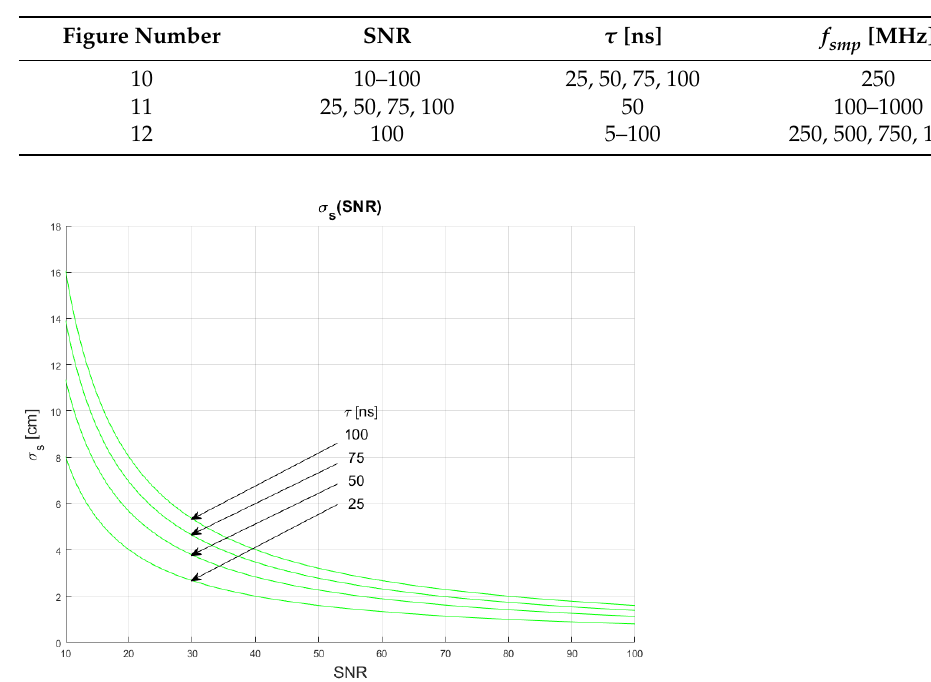
Table 4. Parameters of signals assumed during calculations using Equation (16) for k = 0.536.